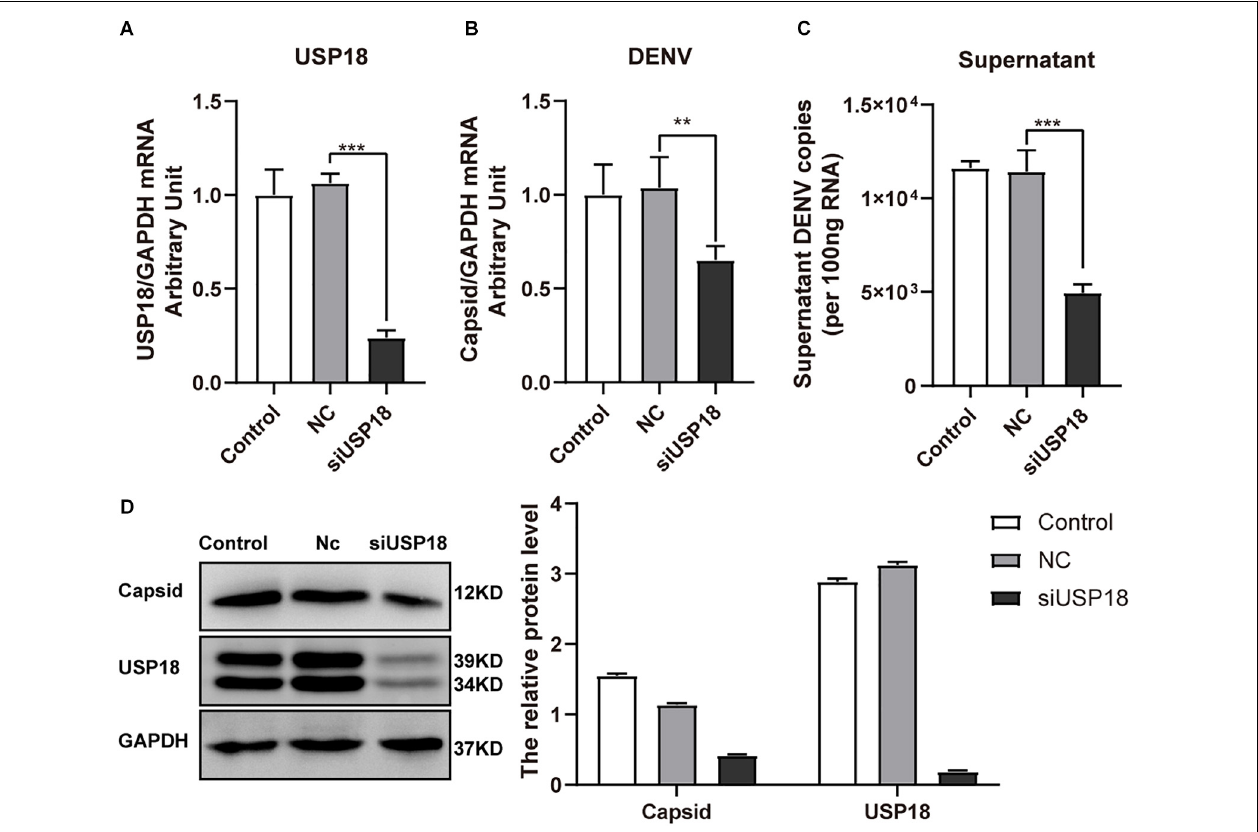
FIGURE 3 | Silencing of USP18 inhibits DENV-2 replication in Hela cells. Hela cells were transfected with siUSP18 or negative control (Nc) for 8 h and then infected with DENV-2 (MOI = 1) for 48 h before cells and culture medium were collected. USP18 knockdown efficiency (A) and levels of DENV-2 RNA (B,C) were determined by real-time PCR. Results were normalized to GAPDH shown as arbitrary units (fold change). Protein expression of USP18 and DENV-2 capsid was assessed by Western blot with GAPDH as a loading control (D) . Control is cells infected with DENV-2 only. Data are presented as mean ± SD; Error bars indicate SD; ** P < 0.01, *** P <